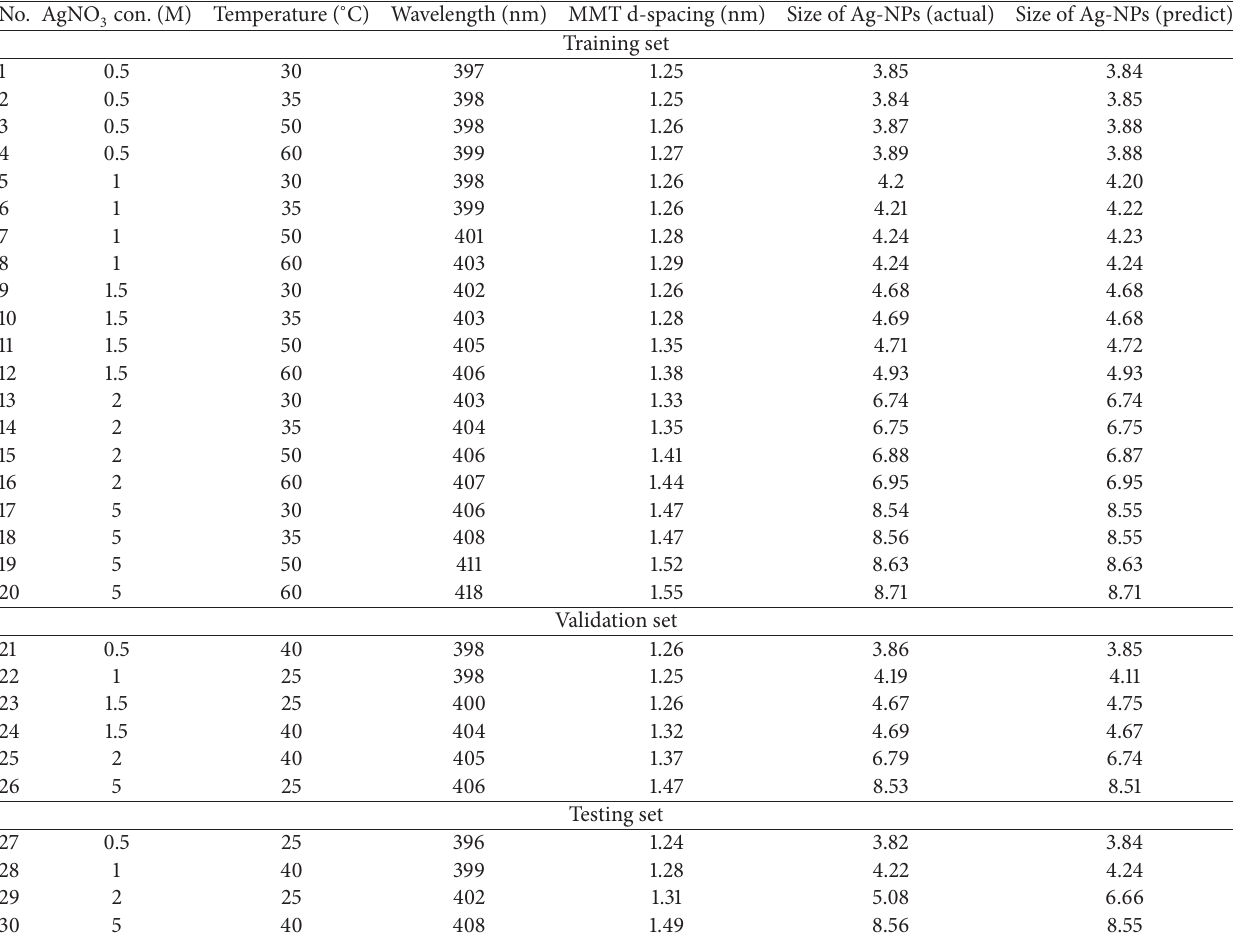
Table 1: Experimental values (training, validation, and testing data set), actual and model predicated of size of Ag-NPs.